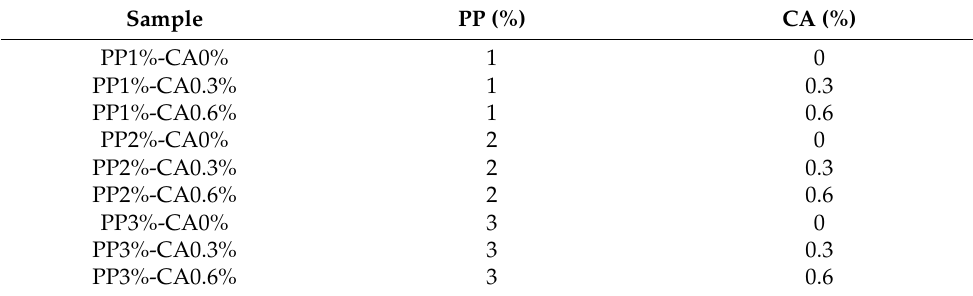
Table 1. Different restructured mackerel mince